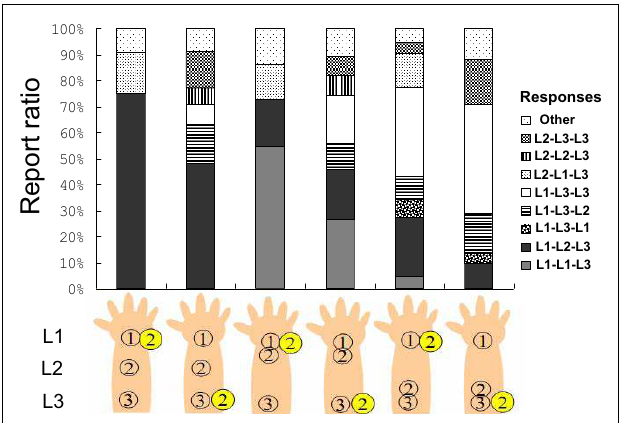
FIGURE 4 |The report ratio in Experiment